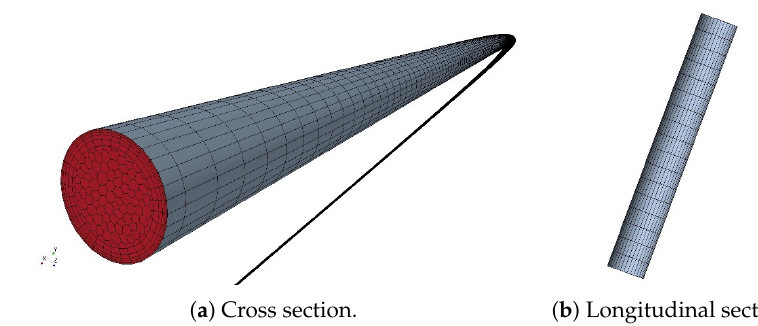
Figure 4. Grid structures of the computational domain.